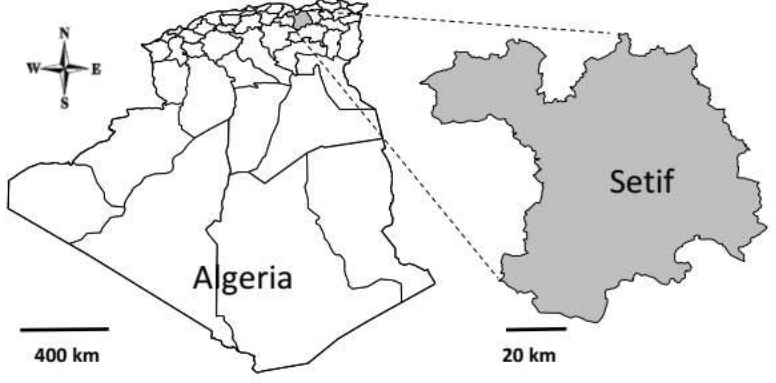
Figure 1. Map of the state of Setif in northeastern Algeria where samples were collected during the period from September 2017 to April 2018 for the detection of C. burnetii infection in cattle.